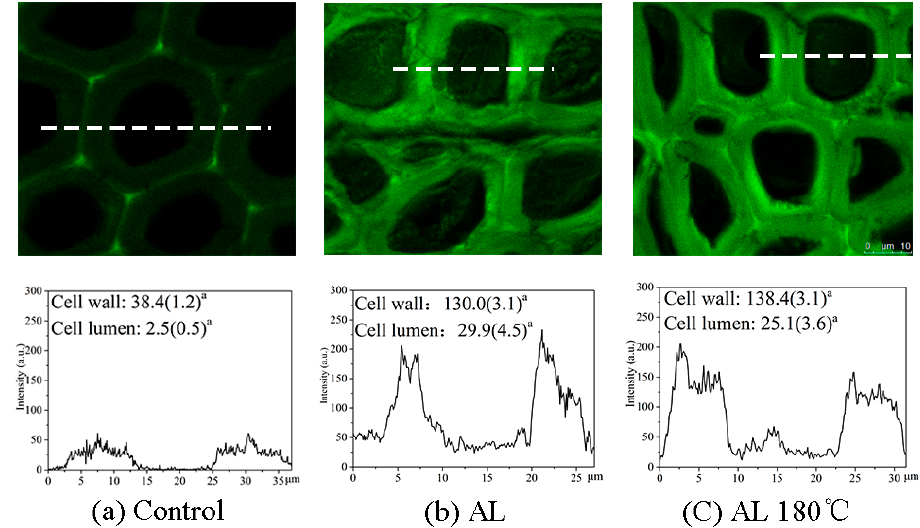
Figure 2. Confocal laser scanning microscopy (CLSM) images showing the lignin distribution over transverse sections of the ( a ) Control, ( b ) AL, and ( c ) AL 180 °C and corresponding varieties of fluorescence signal intensity across the wood cell along the white dotted lines. a Average values (standard deviation) from five replicates are shown.